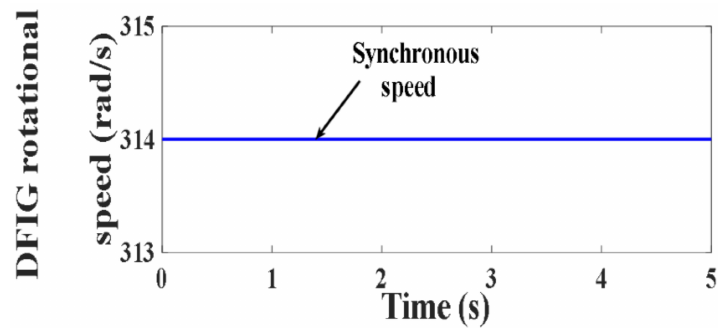
Figure 155. Prime mover operating speeds (rad/s).